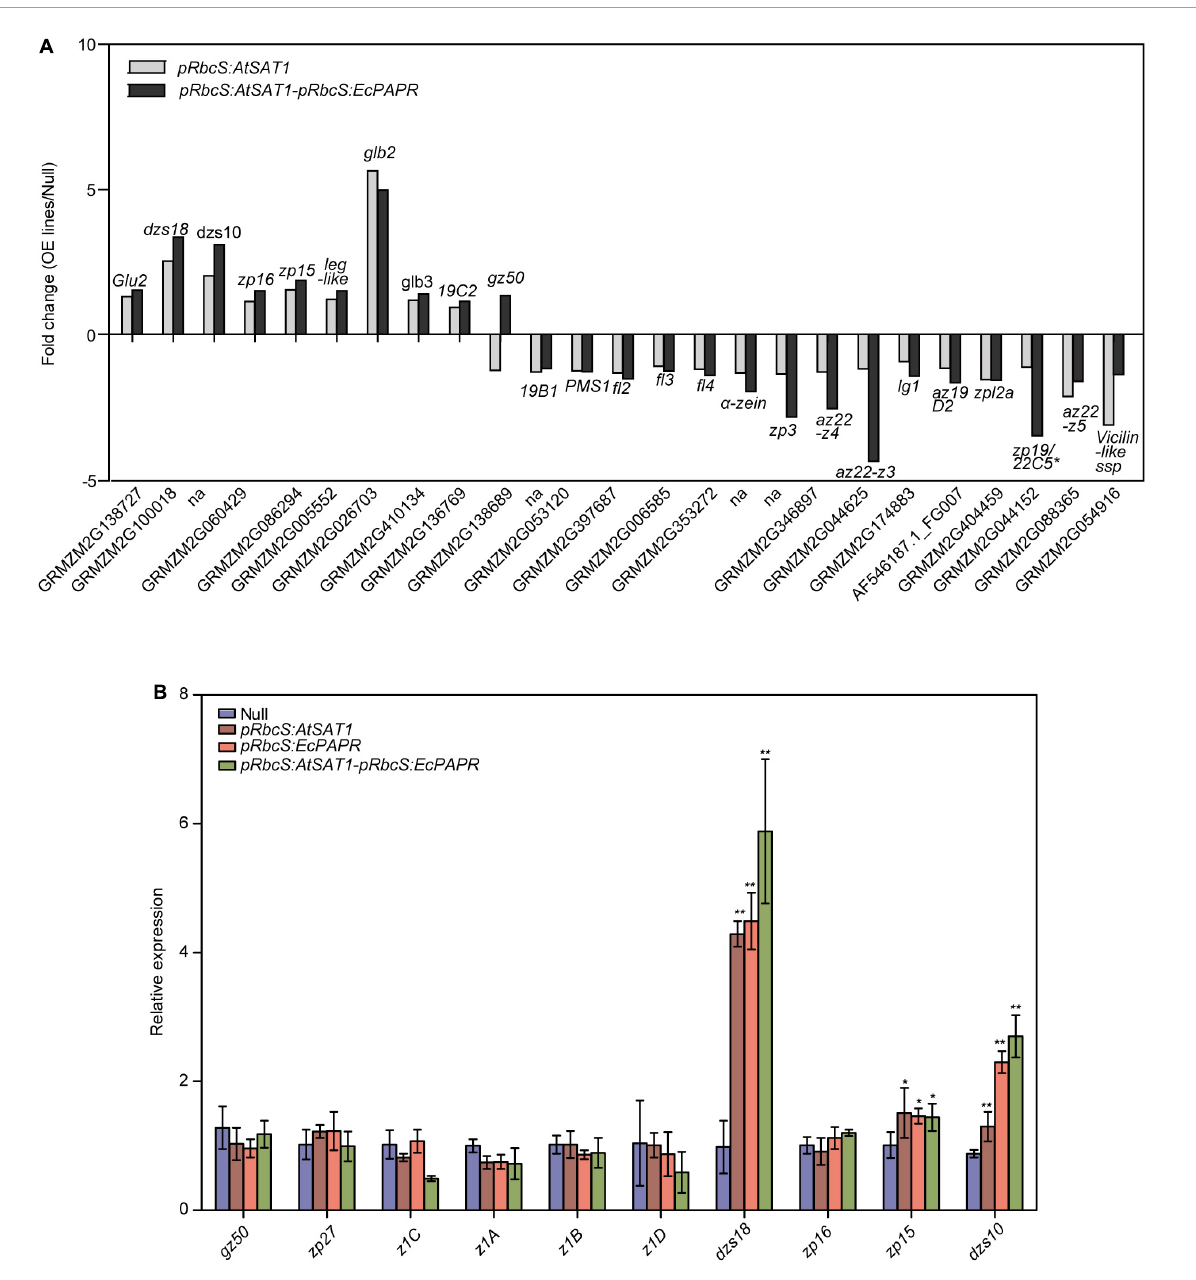
FIGURE5 Comparison of gene expression patterns obtained using RNA-Seq and qRT-PCR. (A) Nutrient reservoir activity-related DEGs in pRbcS:AtSAT1 and pRbcS:AtSAT1-pRbcS:EcPAPR compared with Null. Data were log 2 -transformed and plotted in the bar graph. (B) Expression of gz50, zp27, z1C, z1A, z1B, α z1D, dzs18, zp16, zp15, and dzs10 in the OE lines relative to Null. The data are from three biological replicates per sample and are presented as mean ± SD. Asterisks indicate a significant difference from Null. (Student’s t- test, * p -value < 0.05 and ** p -value ≤